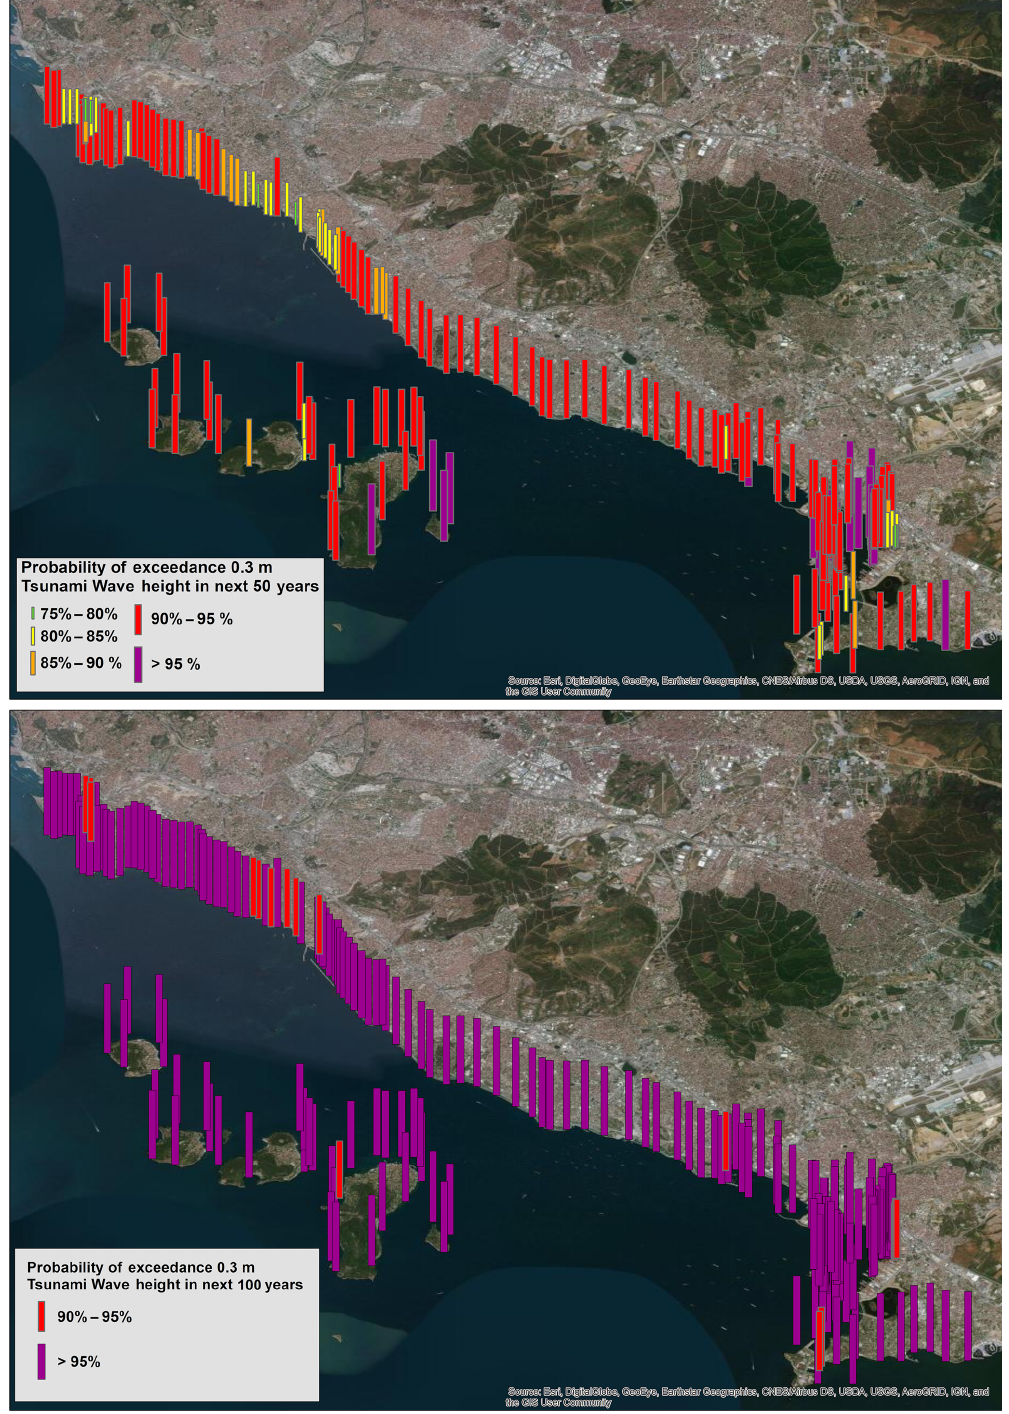
Figure 12. Probability of exceedance of the 0.3m tsunami wave height within the next 50 and 100 years at synthetic gauge points. The yellow rectangles show the Tuzla study domain; change of colors from purple to green on the bars represents the decreasing probability of exceedance (created using ArcMap version